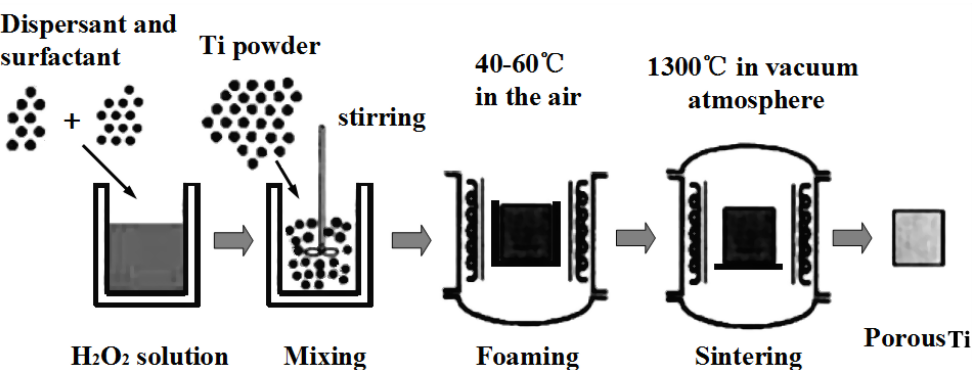
Figure 30. Processing steps for fabricating porous titanium by slurry foaming [311]. Reprinted